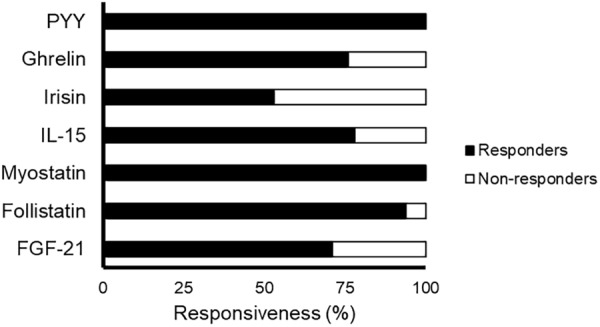
Rate of responsiveness of the blood variables to exercise independently of the training mode. Responsiveness was determined as a positive change greater than the smallest worthwhile change (calculated for each molecule as twice the typical error of measurement and expressed as a percentage). All molecules were measured in 17 subjects except for IL-15 and PYY, which were measured in 9 and 14 subjects, respectively. Abbreviations: FGF21, fibroblast growth factor 21; HIIT1, High intensity interval training session with short intervals; HIIT2, High intensity interval training session with long intervals; IL-15, interleukin-15; PYY, peptide YY; RT, resistance training.